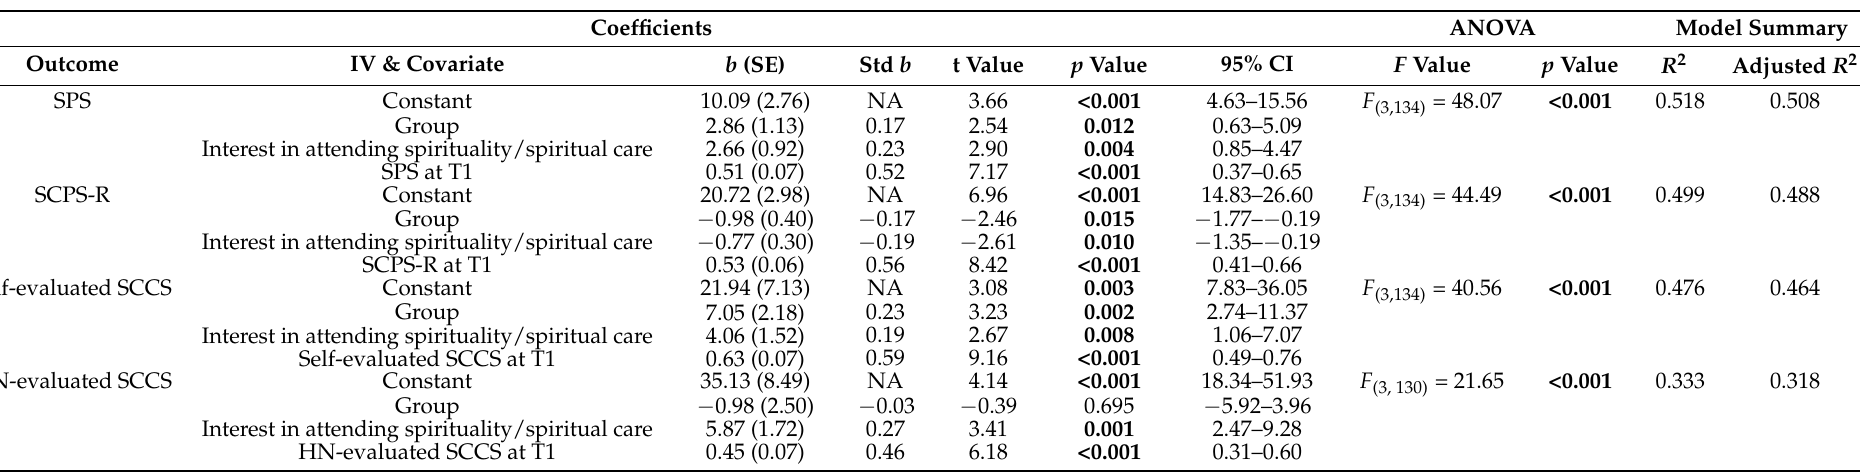
Table A2. Mean differences in outcomes at Time 3 (Observation 3 for EG and observation 2 for CG) by both groups after adjusting for covariates and baseline scores using linear regression ( n = 138).